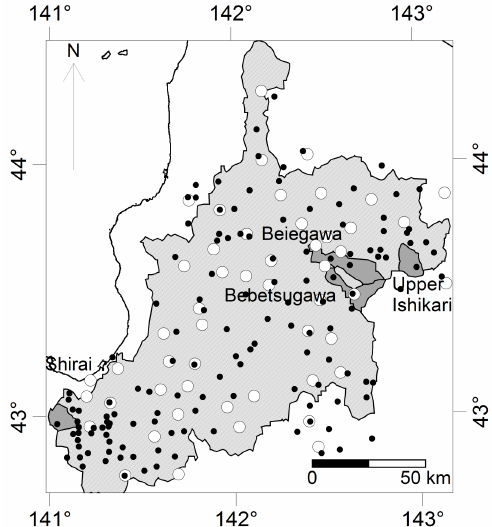
Figure 4. The locations of sub-catchments (grey shaded polygon) that are situated inside the Ishikari river basin (hatched polygon). The dots show the distribution of the AMeDAS rainfall network (white dots) and the MLIT rainfall network (black